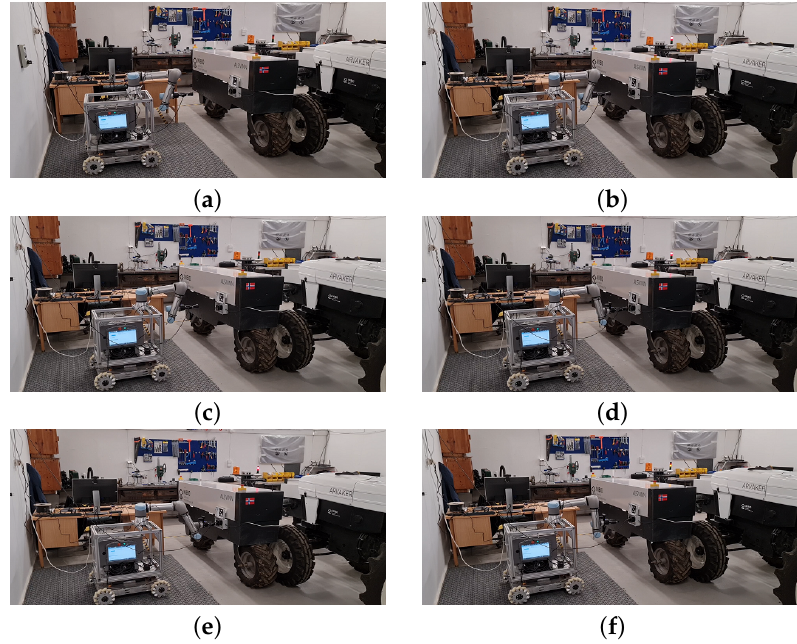
Figure 14. Sequence 3: Plug the cable into the AEV. ( a ) Seq 3.1: Turn the robot arm, then move the gripper down to face the AEV. ( b ) Seq 3.2: Align the ACS to the AEV. ( c ) Seq 3.3: Align the gripper to the AEV fiducial marker. ( d ) Seq 3.4: Move the gripper to the approach point. ( e ) Seq 3.5: Plug the cable to the AEV. ( f ) Seq 3.6: Open the gripper then move back to the waiting